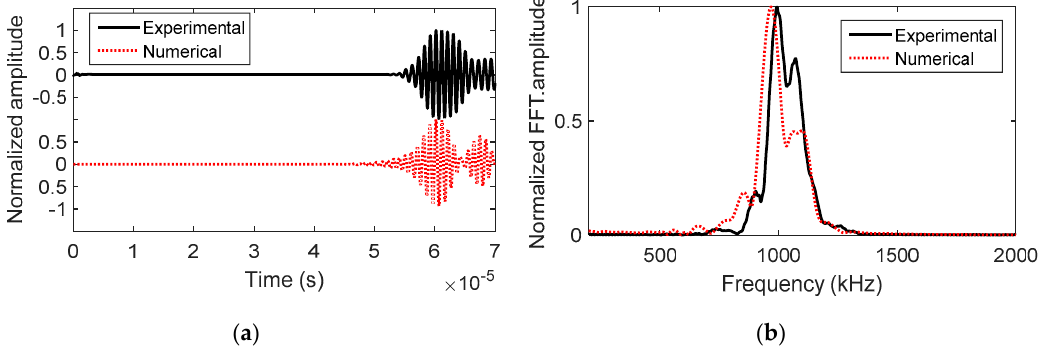
Figure 9. The comparison of experimental and numerical results considering P4 cross section ( a ) time history signals, and ( b ) their frequency spectra.